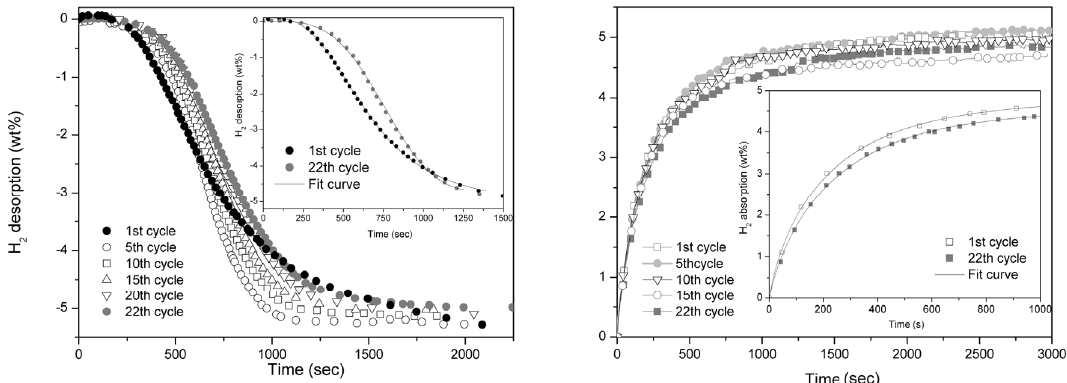
Figure 4. Desorption ( left ) and absorption ( right ) curves of pure MgH and 0.2 bar for desorption and 10 bar for